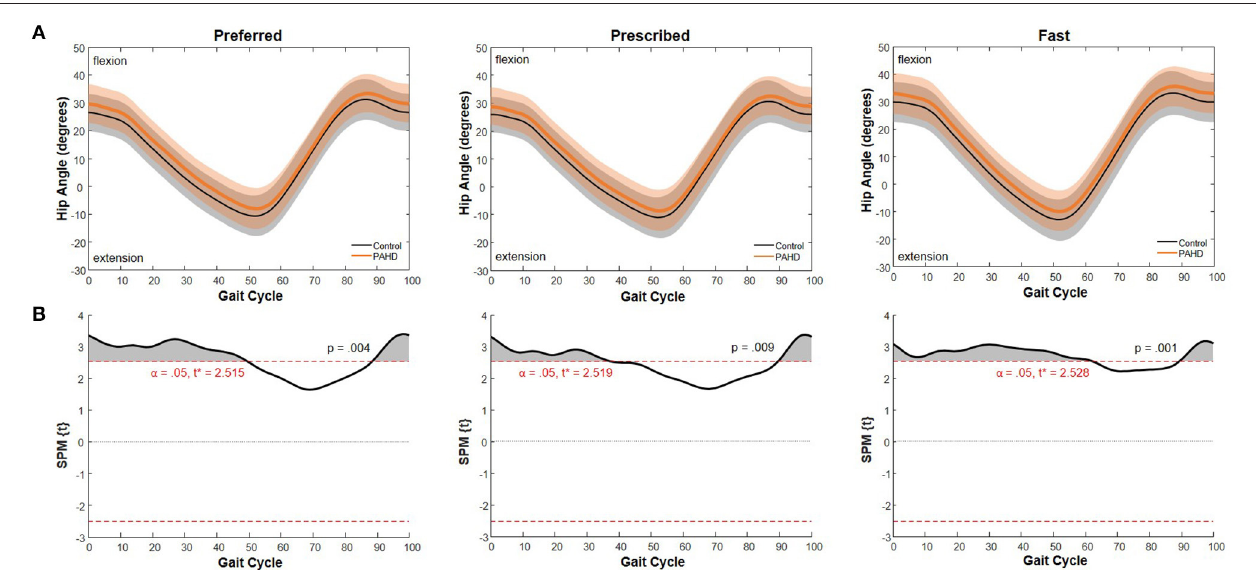
FIGURE 5 | Sagittal Plane Hip Angle: (A) Mean hip angle during walking at a preferred speed for individuals with pre-arthritic hip pain (PAHD group, orange) and healthy individuals without pain (Control group, black). Shading represents one standard deviation above and below the mean. (B) Difference between the two mean curves at each 1% of the gait cycle (SPM{t}) (black), and threshold for significance (dashed line) using a general linear model with sex and walking speed as covariates. Shading indicates supra-threshold clusters where the difference is considered statistically